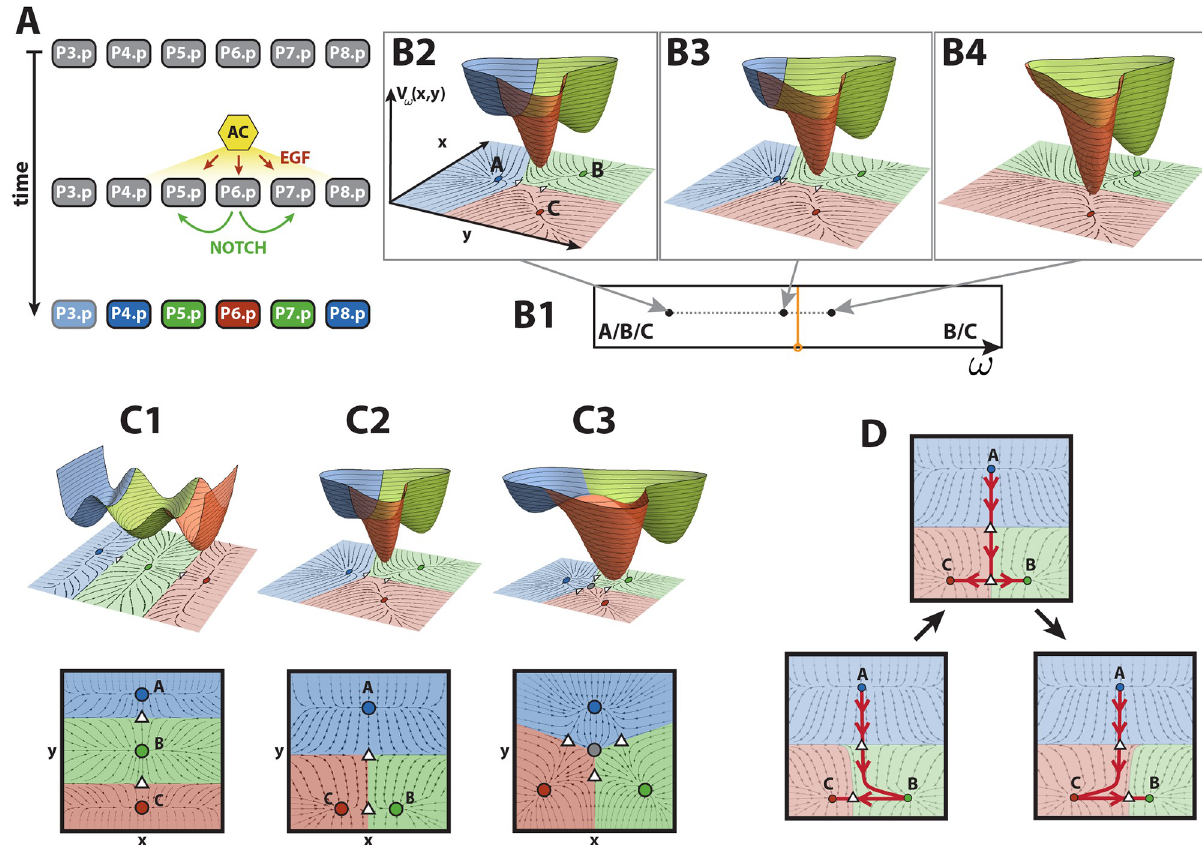
Fig 1. Vulval development in C. elegans and landscape models. (A) Schematic representation of vulval development in C. elegans . Anchor cell (AC) induces vulval precursor cells (VPCs, P3–8.p) to differentiate into three different cell types: primary fate (red), secondary fate (green) tertiary fate (blue). The pattern is controlled by two signals, EGF from the AC (red arrows) and paracrine Notch (green arrows). VPCs are colored according to the WT pattern. P3.p is colored in a shaded blue because it is not included in our study. (B) Example of a bifurcation controlled by a parameter ω in a landscape with three attractors plotted over the corresponding 2-dimensional flow (B2–4) and its corresponding fate map (B1). Attractors and saddles are represented as circles and white triangles, respectively, on the 2-dimensional flow. Attractors and their corresponding basins of attraction are colored accordingly. (B1) Fate map defined by the parameter ω , where the bifurcation set is colored in orange. (B2) For this value of ω , the landscape contains three attractors A , B and C . (B3) A change in the parameter of the potential that is now closer to the bifurcation set produces a change in the stability of the landscape, making the valley corresponding to the blue attractor shallower as the attractor approaches the saddle. (B4) The parameter value has crossed the bifurcation set and is now positioned in another region of the fate map. The bifurcation has happened: the blue attractor has bifurcated away and is no longer present in the landscape. (C) The three possible landscape topologies for a process involving three fates, ordered by simplicity. Basins of attraction and attractors are colored according to the fate they could represent. Saddles and repellers are represented as white triangles and gray circles, respectively. (C1) Thom’s butterfly catastrophe where the three attractors representing the three different cell types are positioned on a curve. This topology corresponds to the morphogen model and is inconsistent with AC ablation data. (C2) 2-dimensional landscape with two decision points: vulval vs non-vulval fate (top saddle) and primary vs secondary fate (bottom saddle). This is the binary flip with cusp landscape and is our choice of landscape. (C3) Symmetric 2-dimensional landscape where all transitions are allowed. This is the landscape studied in [3, 5]. (D) Schematics of the transitions allowed in the binary flip with cusp model. The unstable manifold of the top saddle can flip from attractor B (bottom left) to attractor C (bottom right) by going through an intermediate state where the unstable manifold of the top saddle directs the flow to the bottom saddle (middle top). This intermediate state is called a heteroclinic